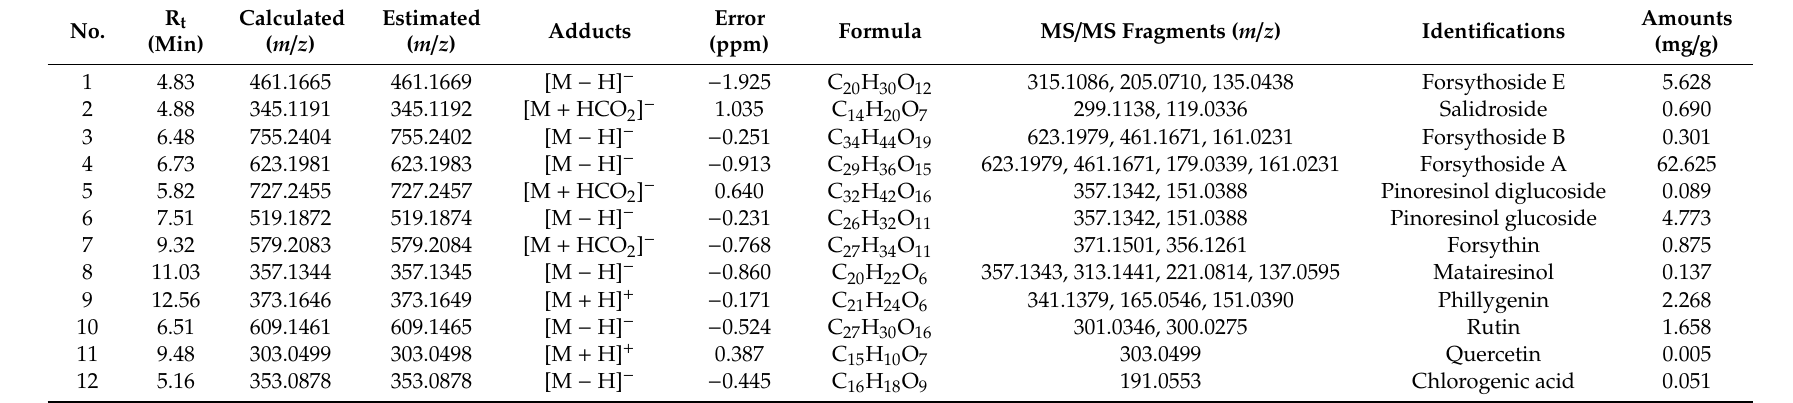
Table 1. Phytochemical constituents of WFS by UHPLC–MS /